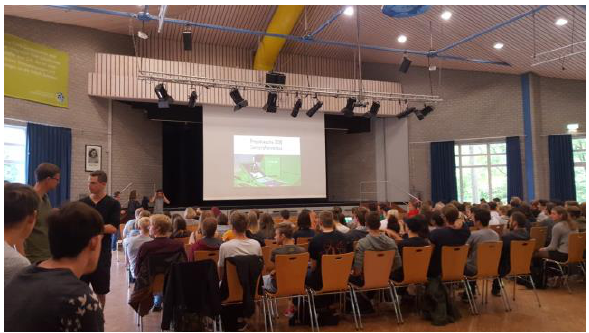
Figure 3: Presentation about the workshop week’s progress to the